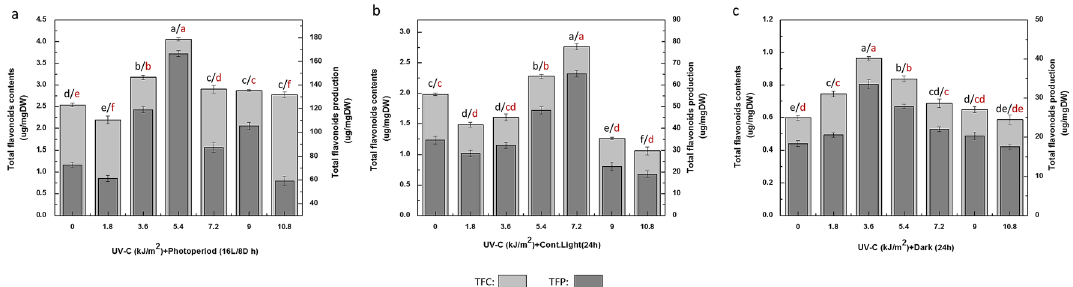
Figure 4. ( a ) Determination of flavonoids contents in callus cultures of Fagonia indica elicited with different doses (0–10.8 kJ/m 2 ) of UV-C radiations and photoperiod (16L/8D h). ( b ) Determination of flavonoids contents in callus cultures of Fagonia indica elicited with different doses (0–10.8 kJ/m 2 ) of UV-C radiations and contineous light (24 h). ( c ) Determination of flavonoids contents in callus cultures of Fagonia indica elicited with different doses (0–10.8 kJ/m 2 ) of UV-C radiations under complete dark (24 h). Values represented as mean ± SE of three replicates. Different (black for TFC, red for TFP) letters represent significant differences between the various experimental conditions ( p <